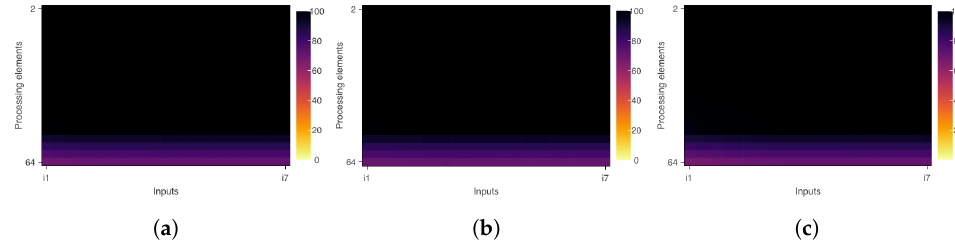
Figure 4. Efficiency diagrams after removing #pragma omp crtical clause. (x-axis = inputs; y-axis = number of threads). ( a ) First region diagram. ( b ) Second region diagram. ( c ) Whole program diagram.